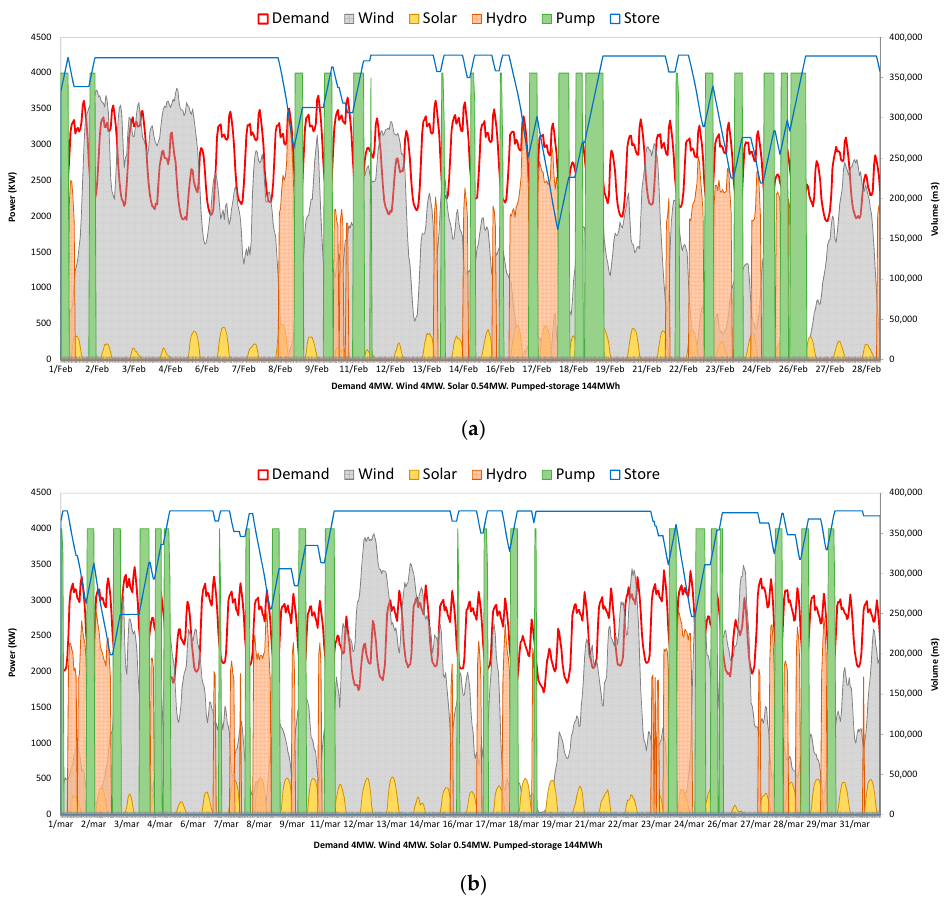
Figure 7. Electricity generation (Wind, PV and Pumped-Storage Hydro) between February ( a ) and March ( b ).